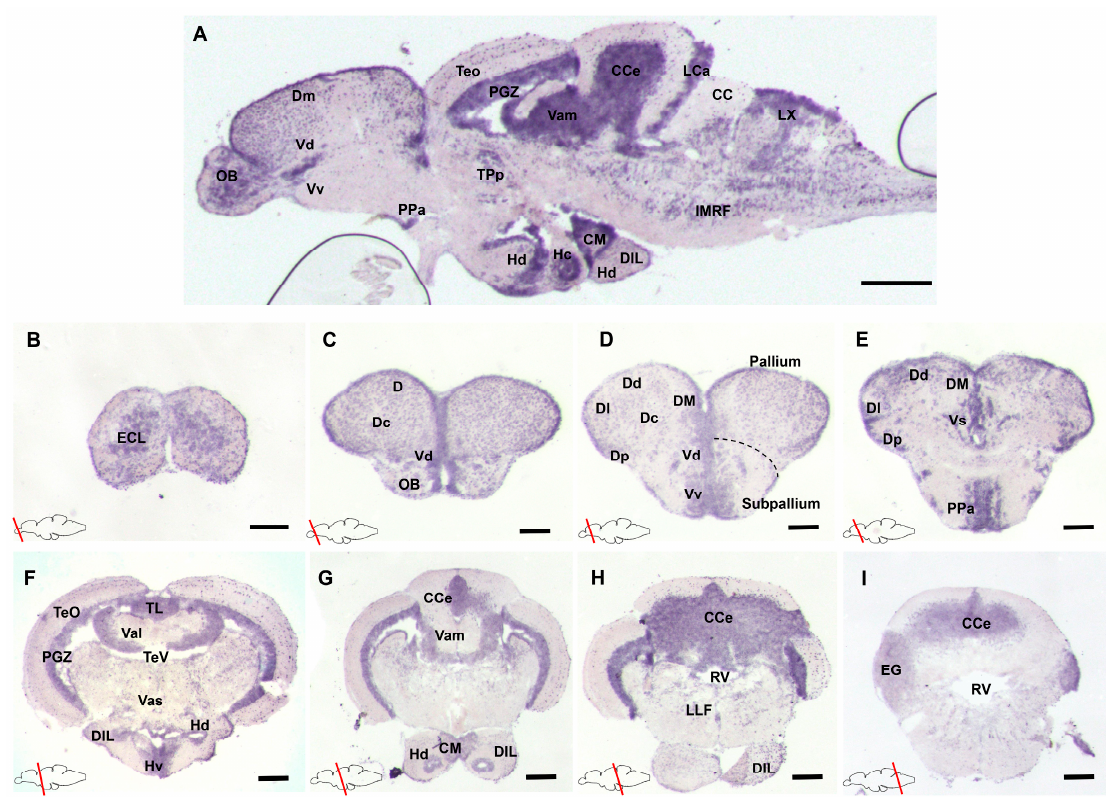
Figure 1. Glial cell line-derived neurotrophic factor (gdnf) expression pattern in the adult zebrafish brain ( A ) Sagittal section of the adult zebrafish brain showing distribution of gdnf mRNA by in situ hybridization in, ( B – E ) telencephalon, ( F – H ) mesencephalon, and ( I ) rhombencephalon. Scale bars: ( A ) 200 µ m ( B – I ) 50 µ m. Abbreviations: CC: Crista cerebellaris; CCe: Corpus